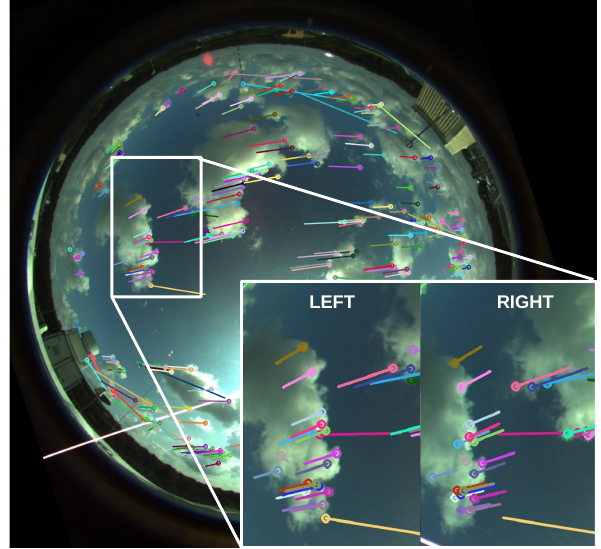
Figure 8. Detected interest points can be matched across the stereo images and are marked by the same color. At least 5 correspon- dences are needed to compute the relative orientation between the cameras and each also provides one 3-D